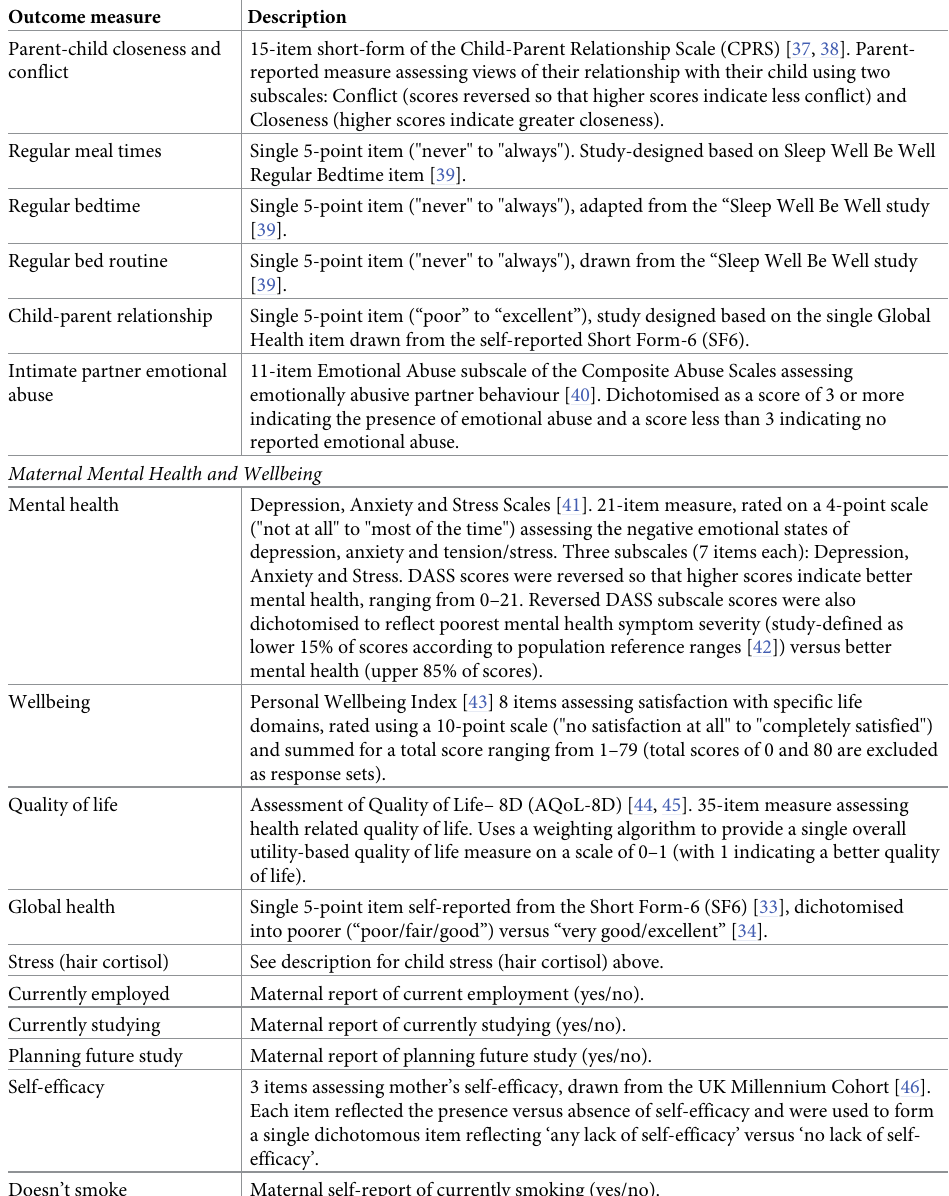
Mean differences (MD) and odds ratios (OR) between intervention and control arms were estimated as measures of treatment effect for continuous and binary outcomes, respectively. Treatment effects were estimated using regression methods (linear or logistic models), adjusted for the stratification factors used during randomisation: parity and study site; and baseline covariates: family’s Socio-Economic Index for Areas (SEIFA) score [49] indicating neighbourhood level disadvantage, maternal education, maternal age at child’s birth, parity, antenatal risk, maternal self-efficacy, and maternal mental health, as well as child sex and age at the 4- and 5-year assessments. All regression analyses accounted for effects of nurse or site clustering using the robust cluster variance estimator